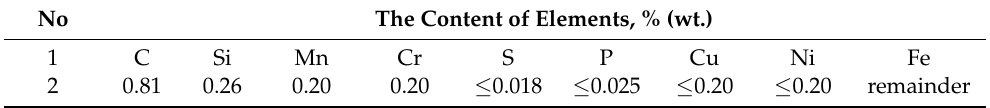
Table 1. Chemical composition of AISI W1-7 steel.